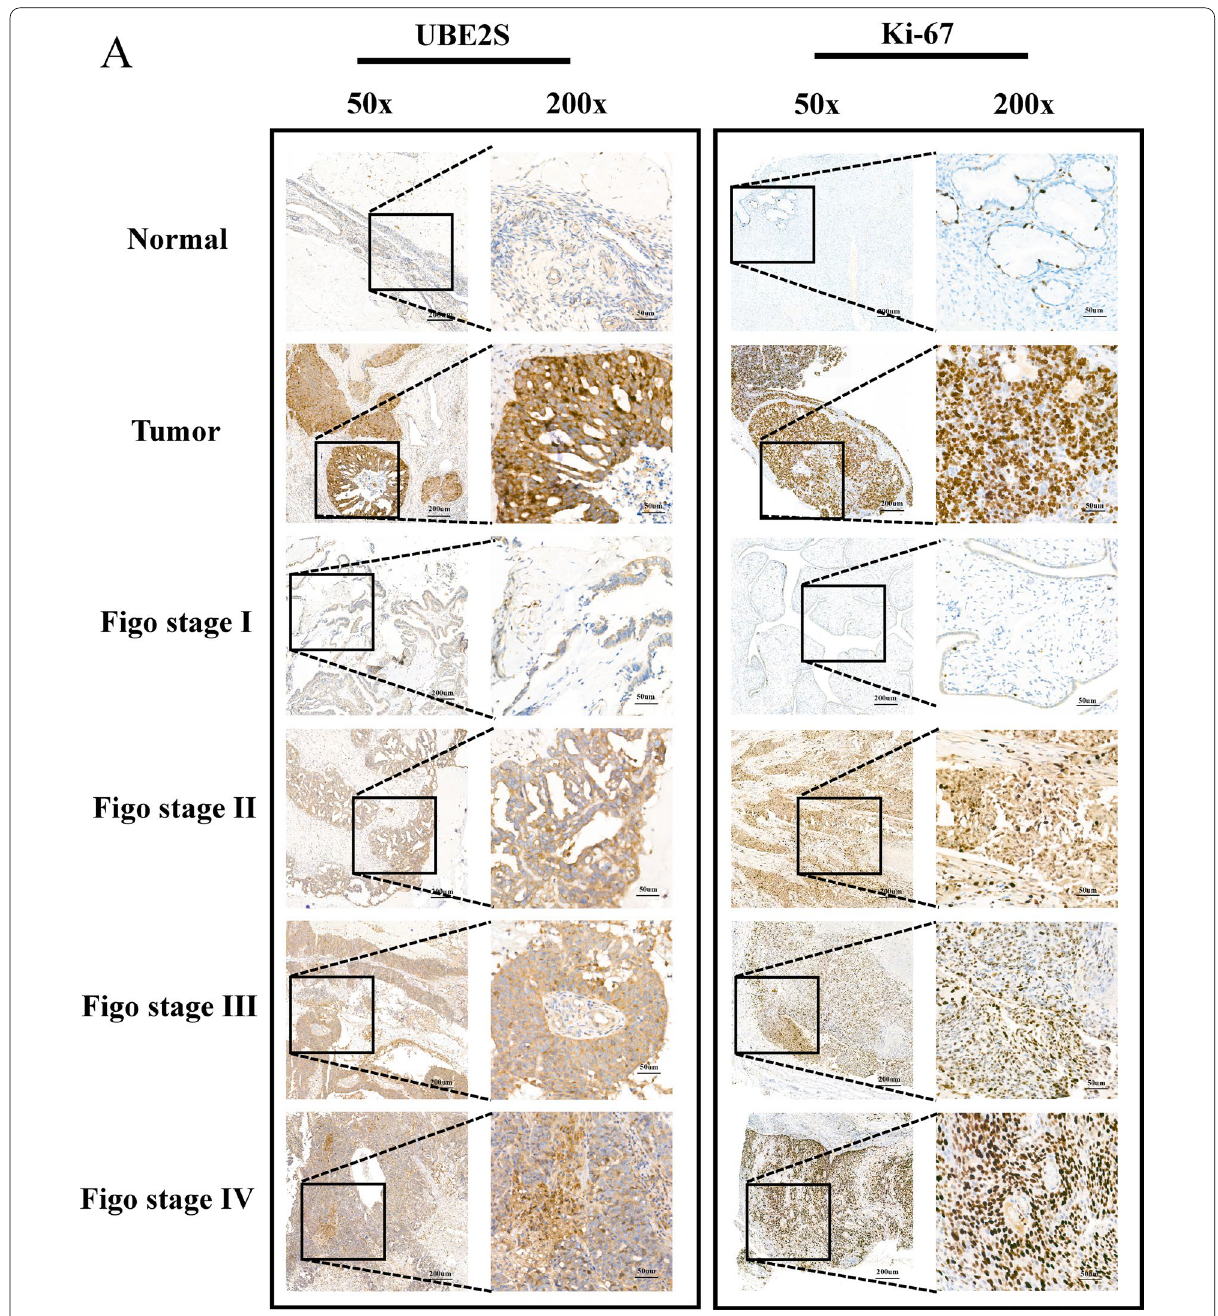
Fig. 4 The expression level of UBE2S and Ki67 in OV based on immunohistochemistry in this study. A The immunohistochemistry atlas of normal ovarian tissue, ovarian cancer tissue and ovarian cancer tissues of different FIGO stages. were shown. The intensity of staining represents the level of